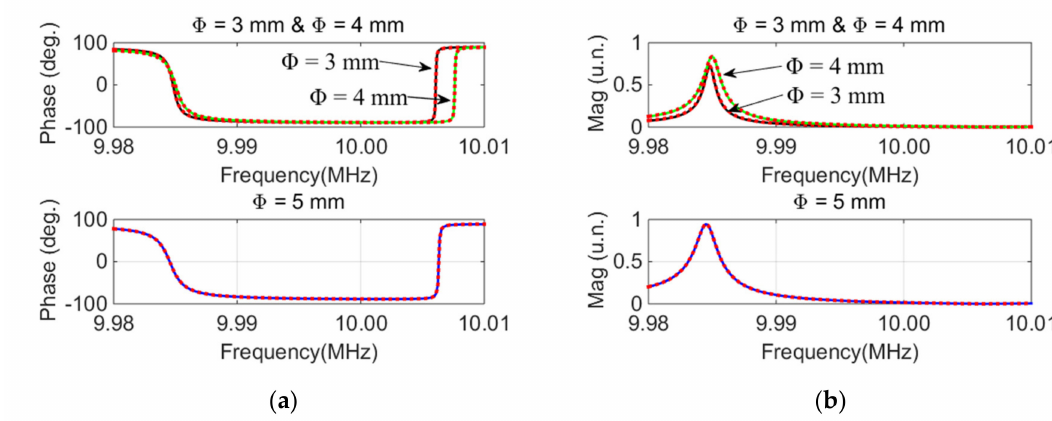
Figure 6. Measured curve and inversion curve of QCM resonator devices with different electrode diameters: ( a ) Phase- frequency curve; ( b ) Magnitude-frequency